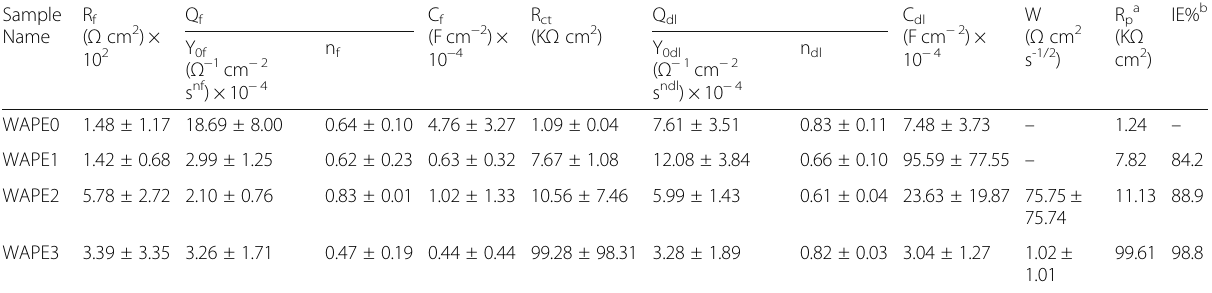
Table 5 EIS parameters obtained by fitting the data to an equivalent circuit for the samples immersed for 7 days in NaCl